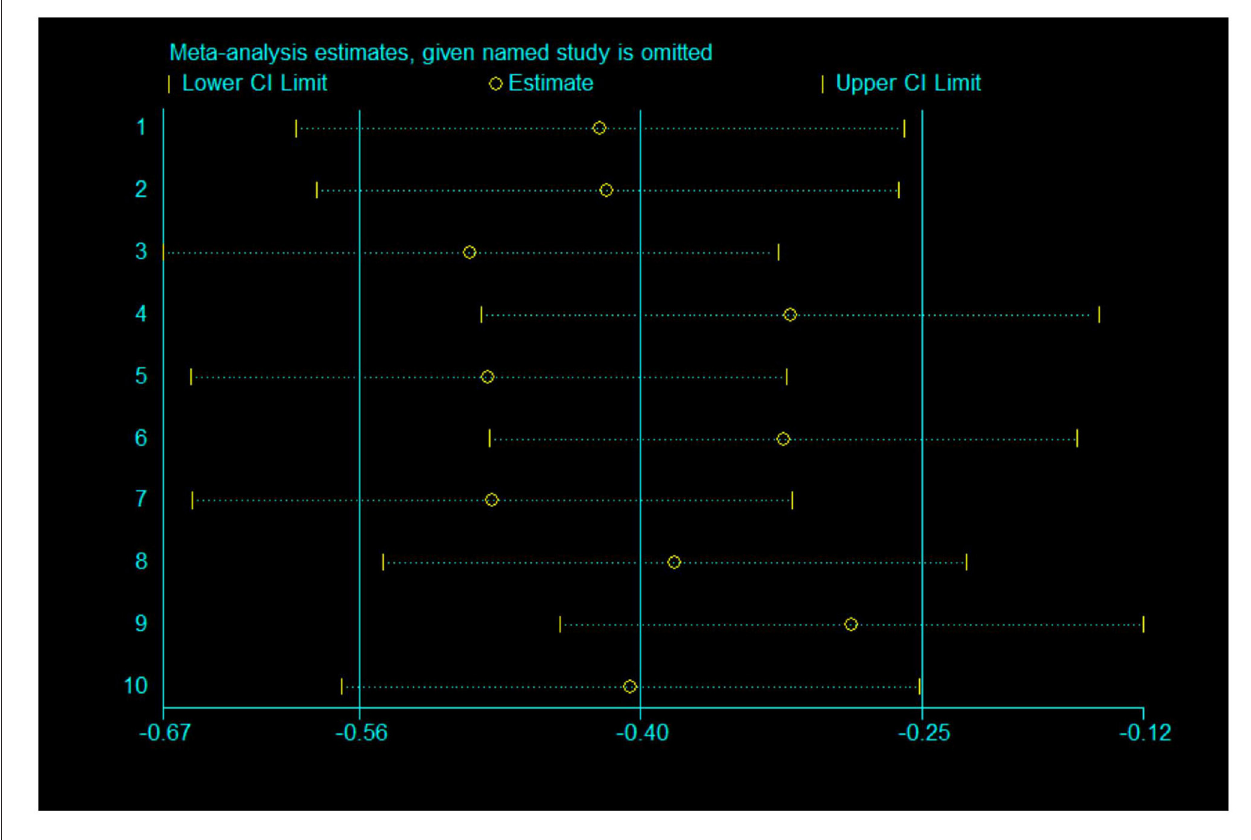
FIGURE 6 | Sensitivity analysis of 10 items for